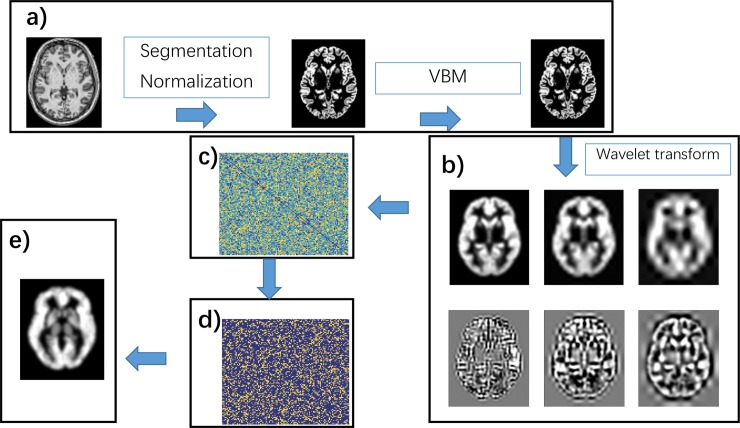
Pipeline for individual voxel-wise morphological connectivity.The pipeline contains the following steps: a) VBM transform; b) wavelet transform; c) Pearson correlation; d) thresholding; e) degree centrality. In pipeline b, the top three images represent the details of the wavelet transform, and the bottom three images represent the approximations of the wavelet transform. The brain mask was constructed by skull-stripping the template image in FMRIB Software Library (FSL).